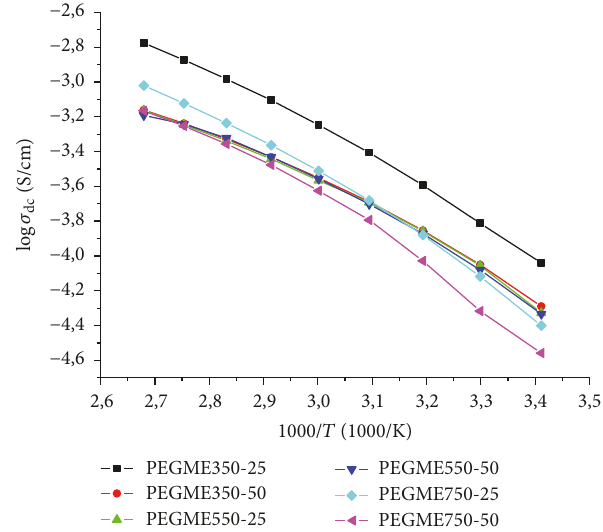
Figure 7: Temperature dependence of the DC conductivities of PEGMEX-B- 𝑌 polymer